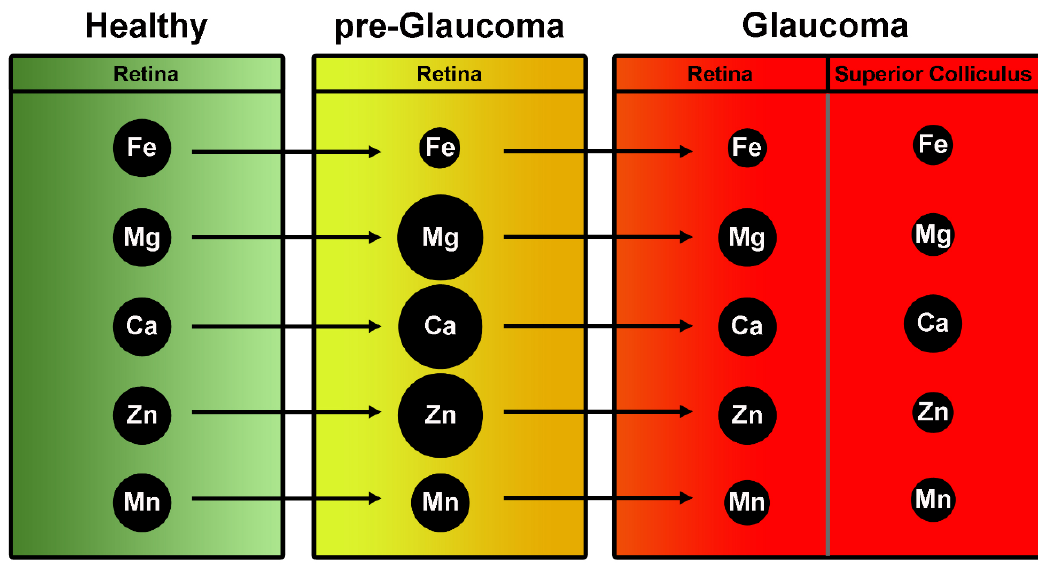
Figure 1. Summary of trace element levels on retinas of a mouse model of glaucoma (DBA2J). Green column indicates the concentration of trace elements expressed in control retinas. In yellow (middle column), levels of trace elements in retinas at pre-glaucomatous stage. In red, trace elements involvement at full-blown stage of pathology. Dimensional change of black spheres simulates the expression of elements at progressive stages of glaucoma.